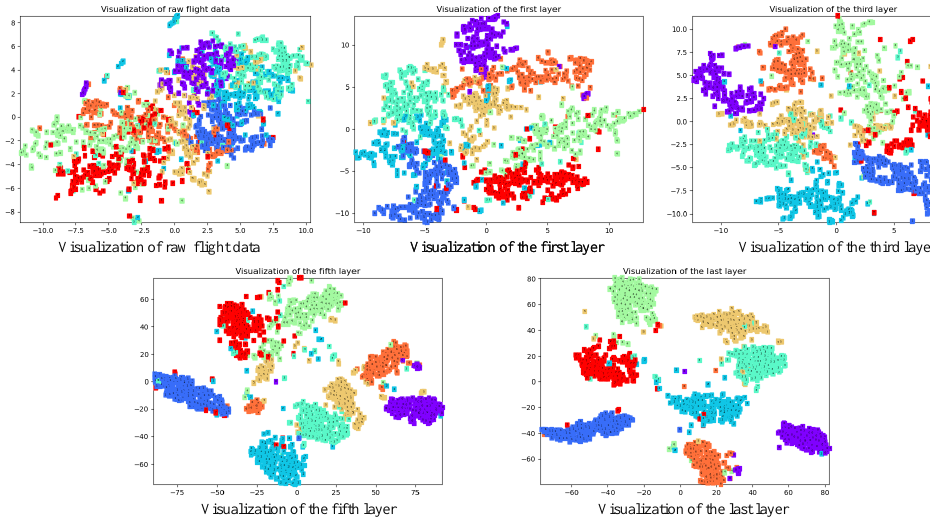
Figure 15. t-SNE Visualization of each layer of neural network.